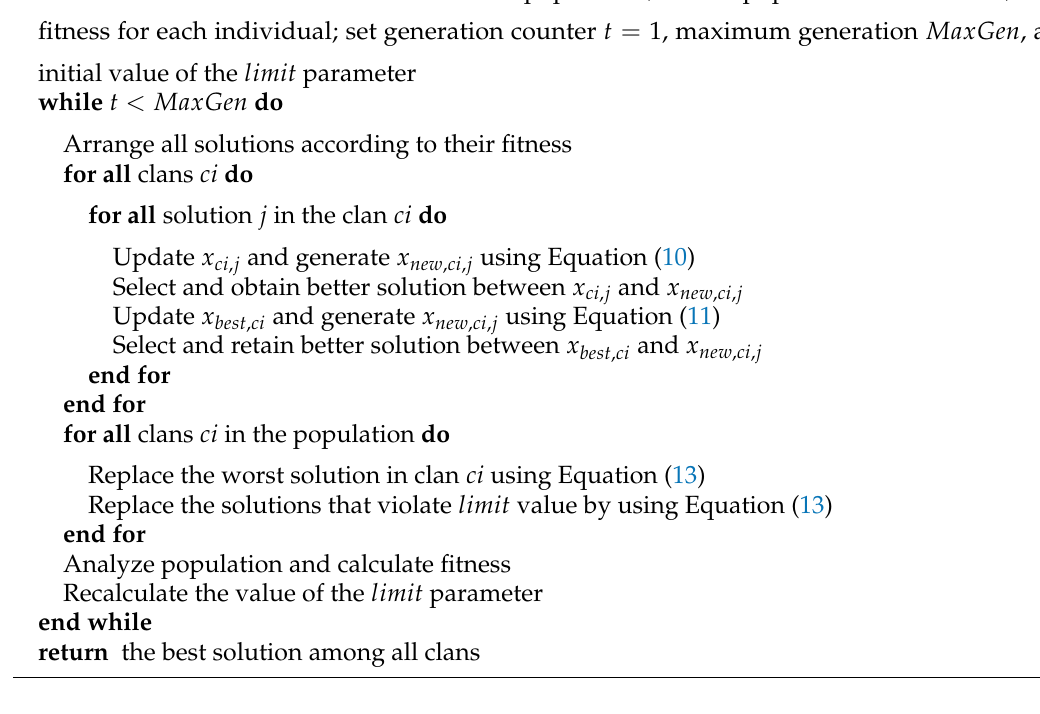
Algorithm 2 Pseudo code of the HEHO algorithm